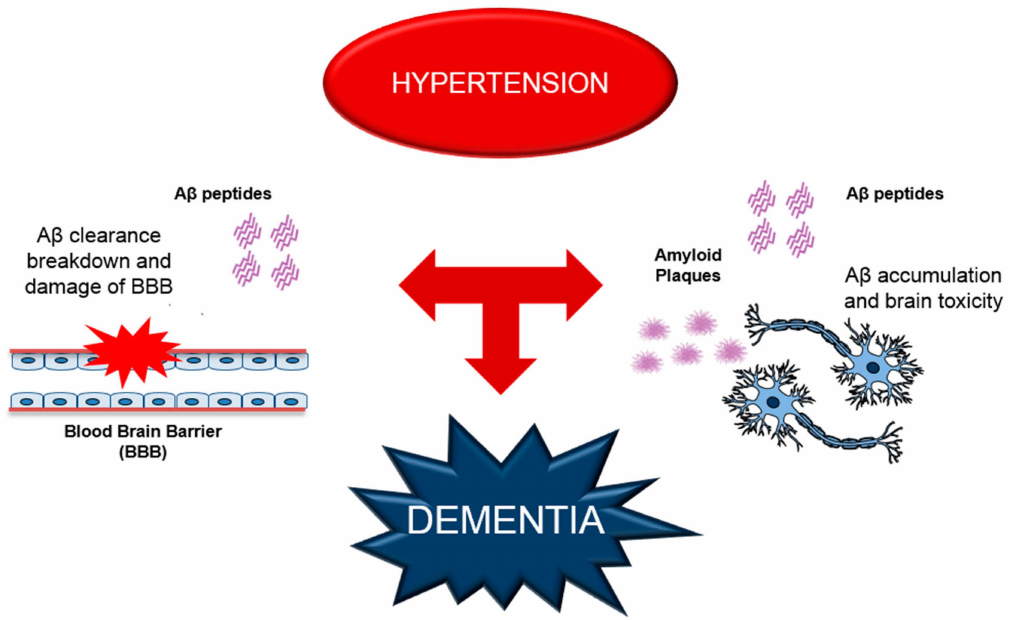
Figure 1. Schematic representation of hypertension-induced alterations, leading to dementia. Hypertension negatively affects the mechanisms of A β clearance causing a damage of BBB (blood brain barrier) and increase of A β accumulation in the brain, aggravating the synaptic dysfunction and the brain toxically. All these effects contribute to the deterioration of cognitive